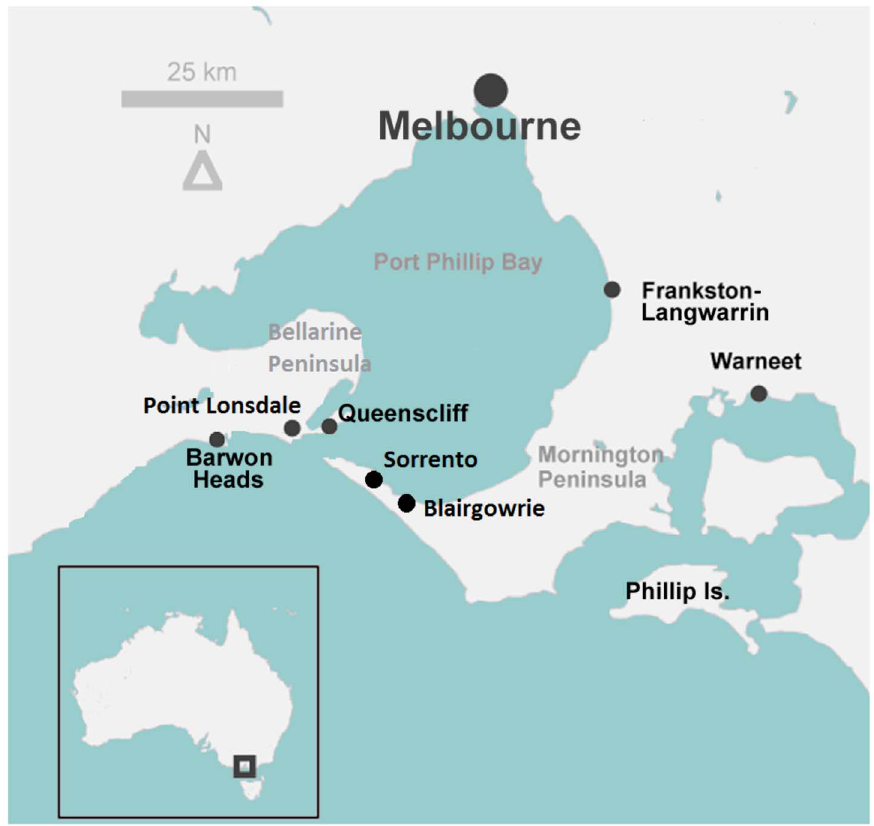
Figure 1. Map showing the Mornington and Bellarine peninsulas, and locations of towns referred to in the text.